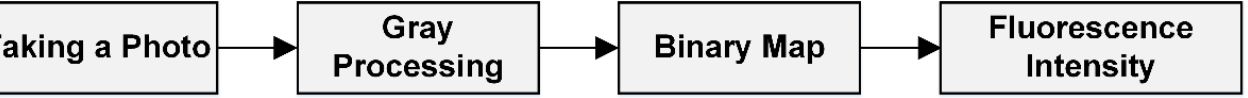
8 of 13 Figure 4. Pictures of the app interface. ( a ) Start-up screen; ( b ) Fluorescence photo capture interface; ( c ) Photo-processing interface and result output; ( d ) Binary map of fluorescence photo and distribution chart of fluorescence intensity. The principle to obtain fluorescence intensity is shown in Figure 5. Briefly, the origi- nal fluorescence photo is first transformed to a gray map based on following equation: 𝐺𝑟𝑎𝑦 𝑣𝑎𝑙𝑢𝑒 = 0.299 × 𝑟𝑉𝑎𝑙𝑢𝑒 + 0.587 × 𝑔𝑉𝑎𝑙𝑢𝑒 + 0.114 × 𝑏𝑉𝑎𝑙𝑢𝑒 (1)